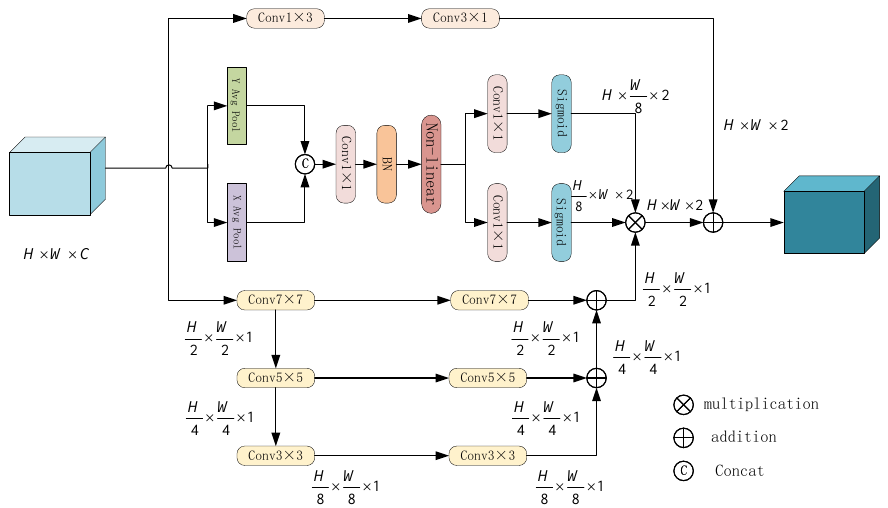
Figure 3. Deep Feature Extraction